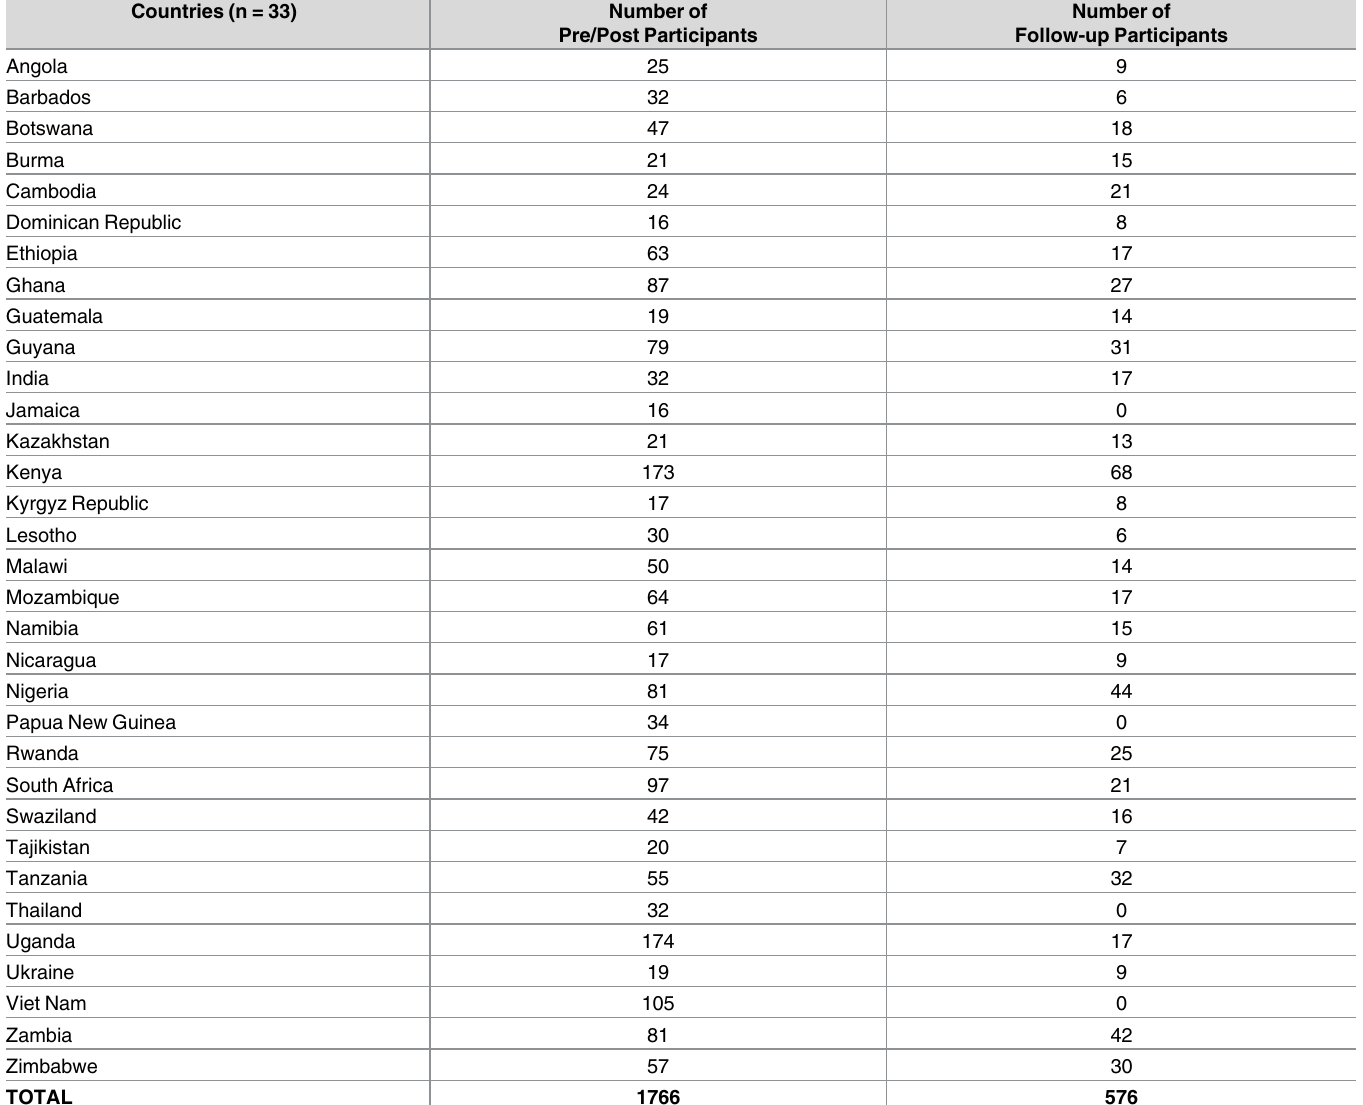
Table 1. Number of gender and sexual diversity training participants by